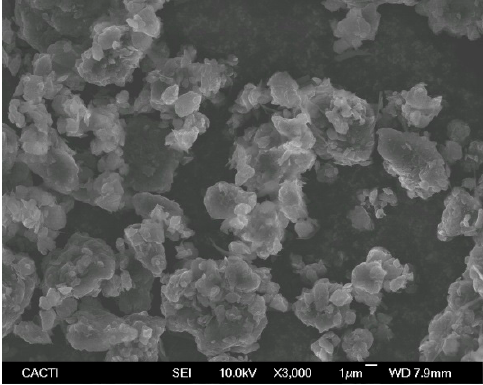
Figure 1. SEM image of sulfonic acid-functionalized graphene nanoplatelets at 3000× magnification.